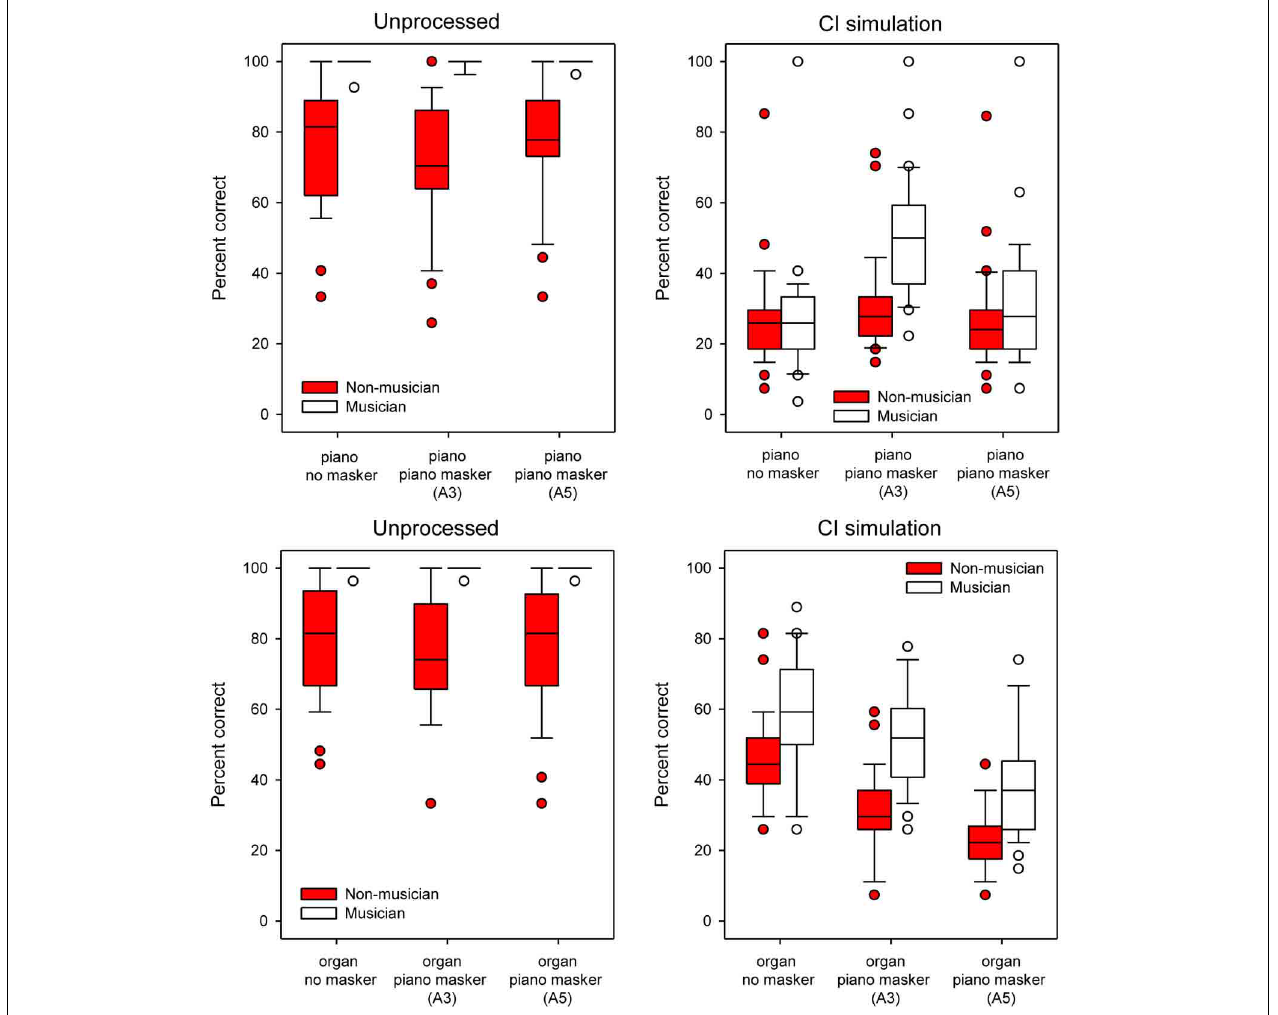
FIGURE 9 | Boxplots for MCI performance for each masker condition for musicians and non-musicians. The top and bottom panels show data for the piano and organ targets, respectively. The left and right panels show data with unprocessed stimuli or with